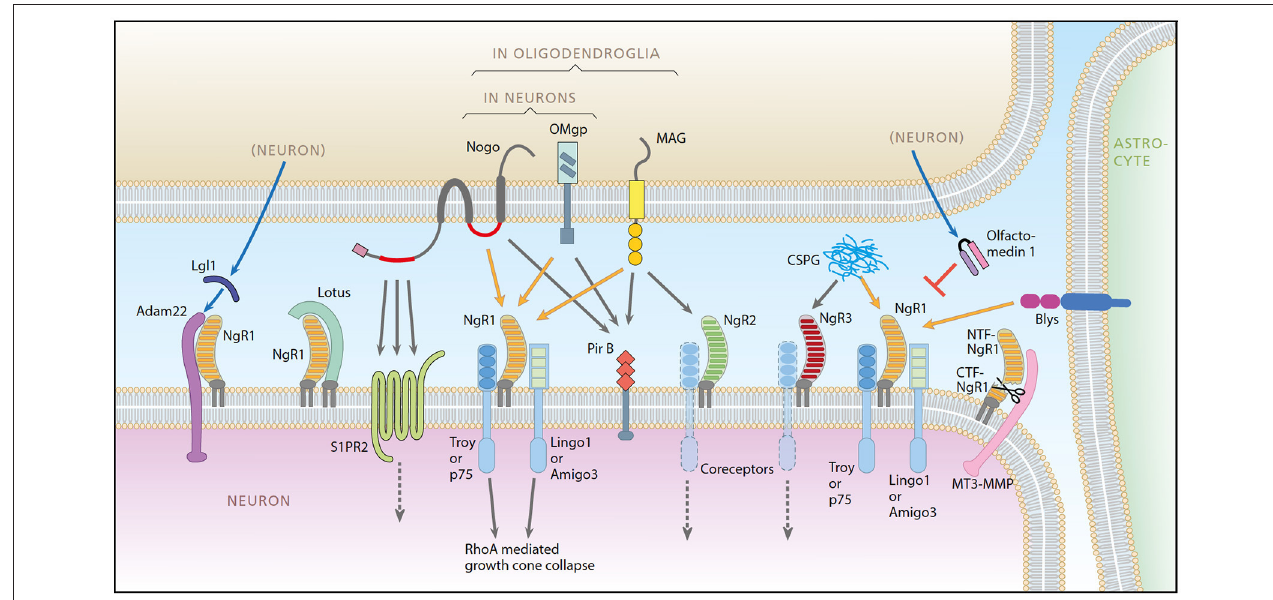
FIGURE 1 | A schematic representation of the Nogo system. Ligands: Nogo-A, OMgp, MAG, Blys. Receptors: NgR1, NgR2, NgR3, PirB, ADAM22, S1PR2. Coreceptors: Troy, P75, Lingo-1, Amigo3. Modulators: LOTUS, LgI1, Olfactomedin, CSPG, MT3-MMP. Picture from Karlsson et al.